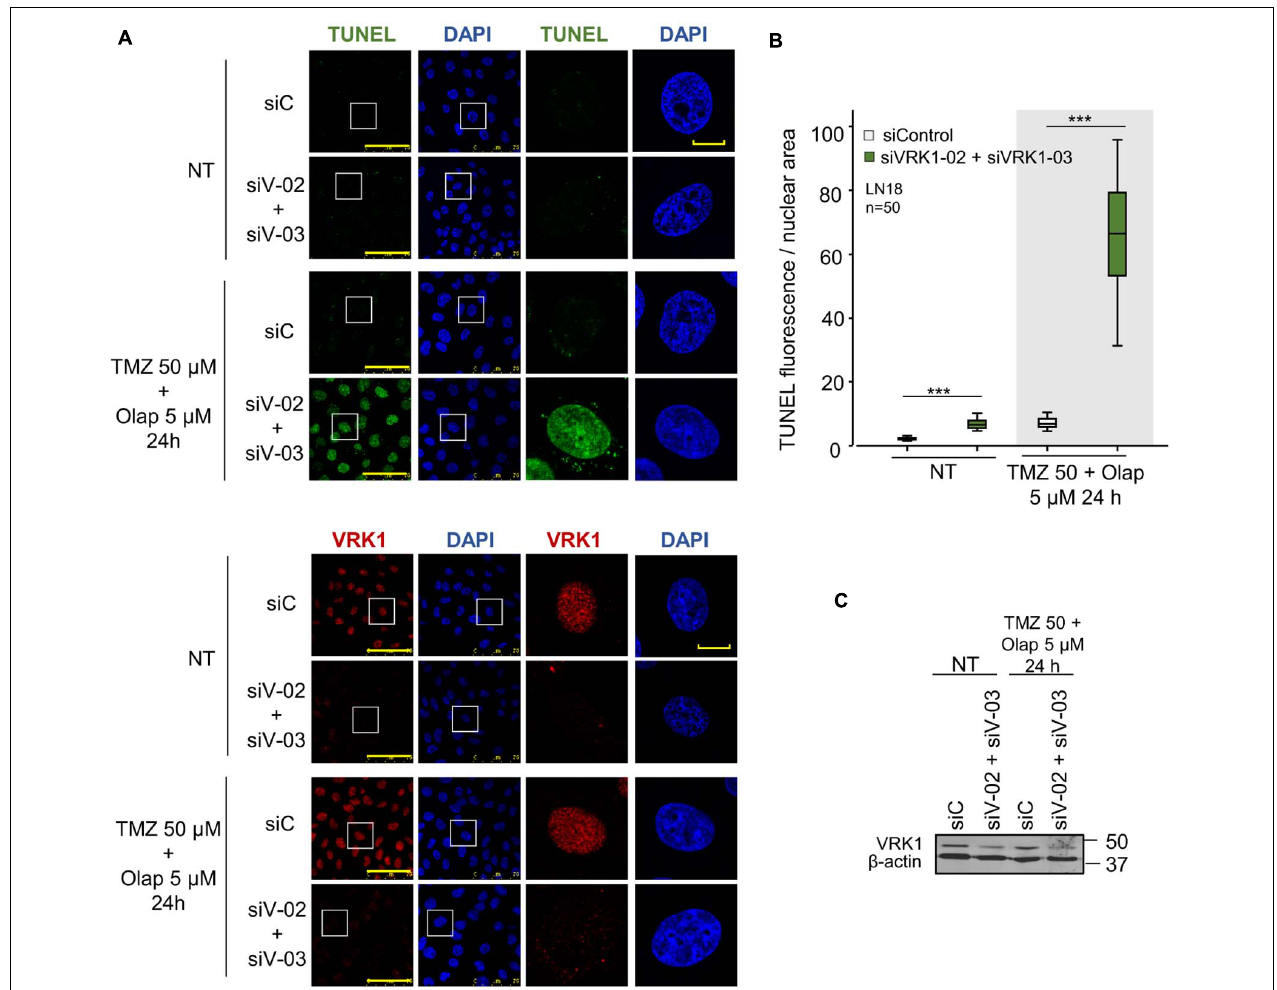
FIGURE 6 | Effect of VRK1 knockdown on DNA damage induced by TMZ and olaparib treatments in LN-18. (A) Effect of siControl and the combination of siVRK1-02 and siVRK1-03 on DNA damage induced by TMZ, olaparib and the combination of both drugs. Free DNA ends resulting from DNA damage were detected in TUNEL assays. (B) Quantification of the effect of VRK1 depletion on DNA damage. Fifty cells per condition were quantified. Scale bar = 15 µ m. *** p < 0.001. (C) Western blot showing the effect of VRK1 knockdown. β -actin was used as load control. NT: no